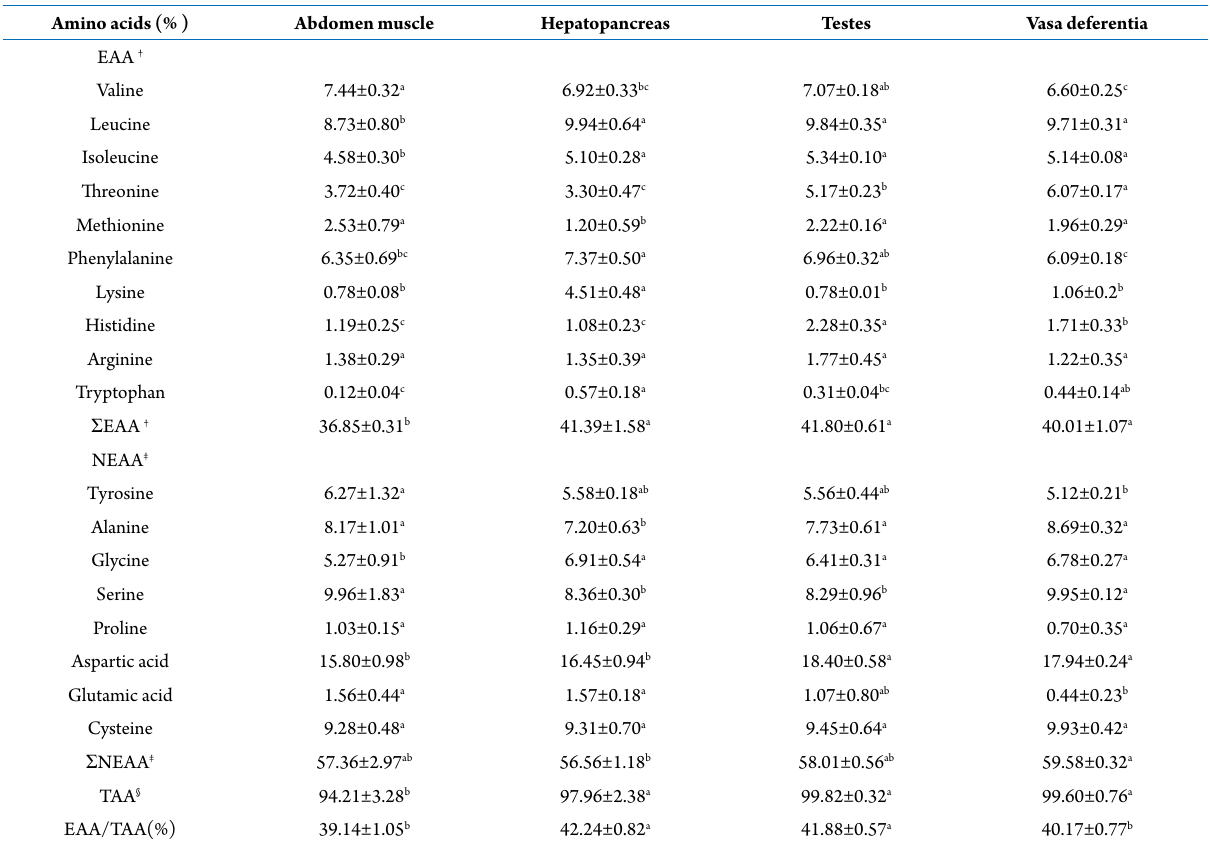
Table 2. Amino acid composition in the abdomen muscle, hepatopancreas, testes and vasa deferentia (%, wet weight) during the reproductive season in male Pontastacus leptodactylus.